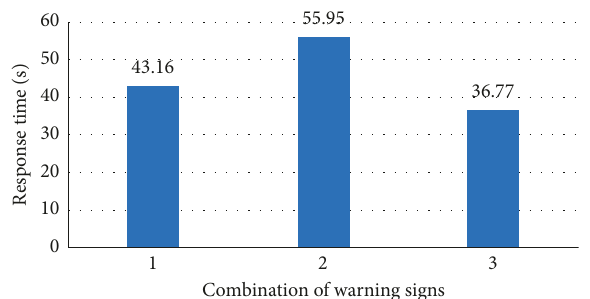
Figure 4: Mean value chart of time-based indicators.